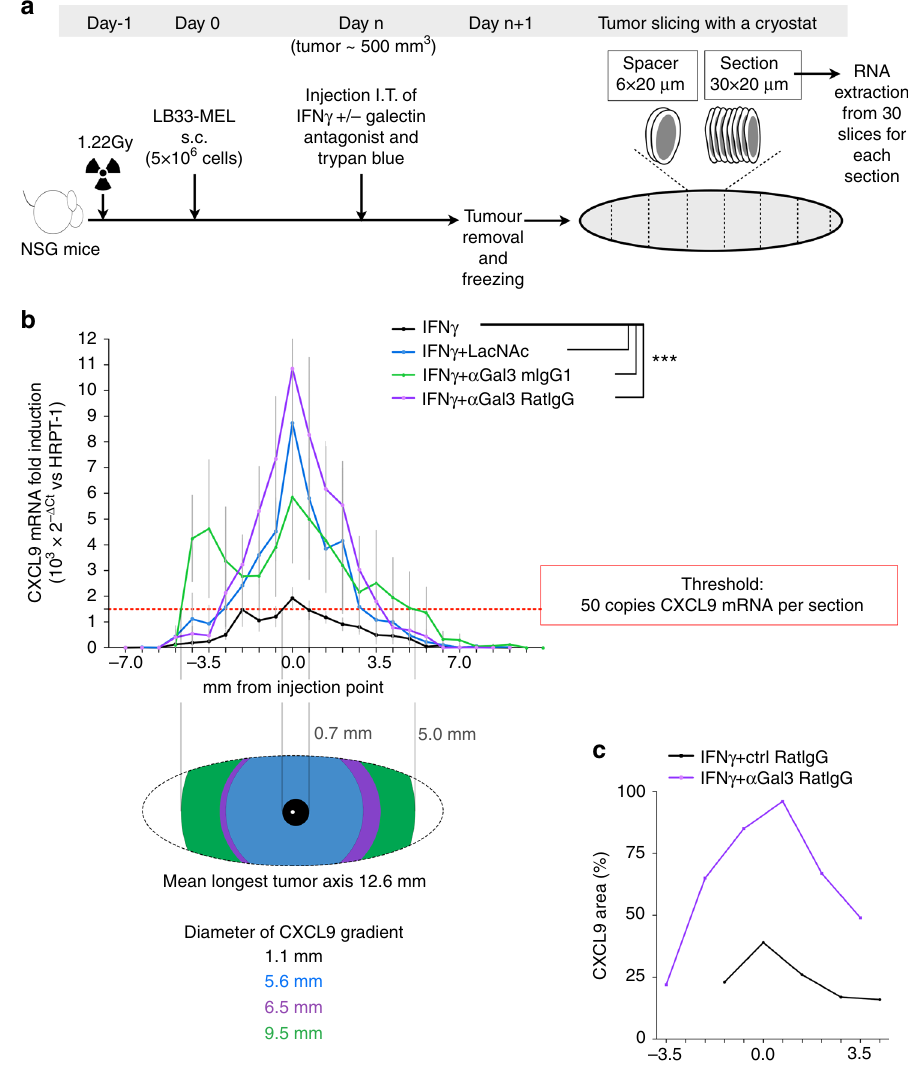
Fig. 5 Spreading of IFN γ signaling in tumor xenografts treated in vivo with galectin antagonists. a Scheme showing the protocol for analyzing IFN γ signal diffusion along the tumor. s.c. stands for subcutaneous injection and I.T. for intratumoral injection. b CXCL9 fold induction along the tumor sections. Mice treated with IFN γ alone (50 ng per tumor), or together with galectin antagonists LacNAc (0.1 μ mol per tumor) or antibodies (100 ng per tumor). Mean ± SEM of eight independent tumors for each treatment. For CXCL9 induction in individual tumors see Supplementary Fig. 6a. *** P < 0.0001; Wilcoxon matched-pairs signed rank test with Dunn ’ s Multiple Comparison Correction Test. The red dotted line marks the threshold of 50 CXCL9 mRNA copies per section of the tumor. Each section represents 0.66 mm thick, contains 30 tumor slices, and about 1 – 4 millions cells. The drawing below shows the diffusion of CXCL9 gradient along the tumor taking into account the threshold. c Quanti fi cation of CXCL9 staining area in immunohistochemistry images of several sections of tumors treated with IFN γ and either a control isotype antibody or an anti-galectin3 ratIgG antibody. Representative images are shown in Supplementary Fig.